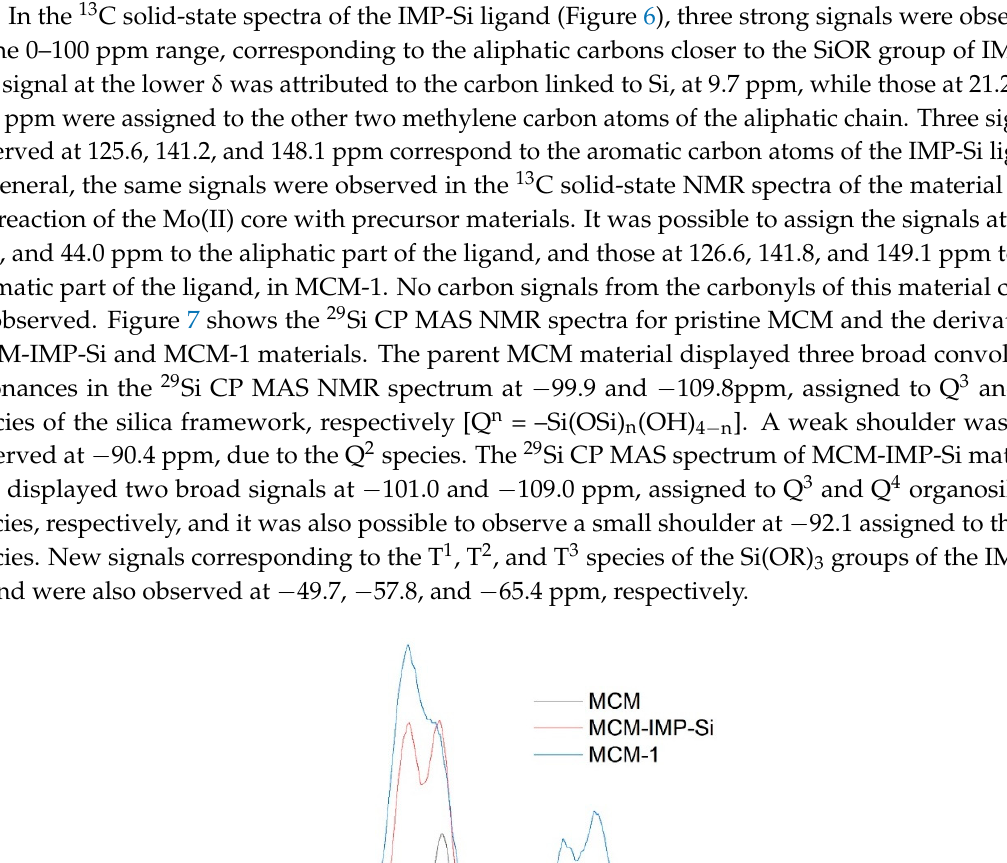
Figure 6. 13 C CP MAS NMR spectra of materials MCM-IMP-Si and MCM-1.